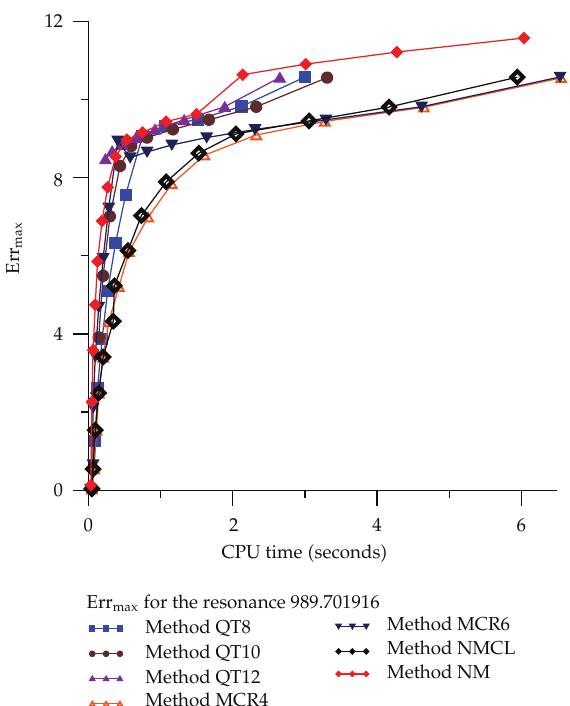
Figure 5: Accuracy (cid:4) Digits (cid:5) for several values of CPU Time (cid:4) in Seconds (cid:5) for the eigenvalue E 3 (cid:6) 989 . 701916. The nonexistence of a value of Accuracy (cid:4) Digits (cid:5) indicates that for this value of CPU, Accuracy (cid:4) Digits (cid:5) is less than